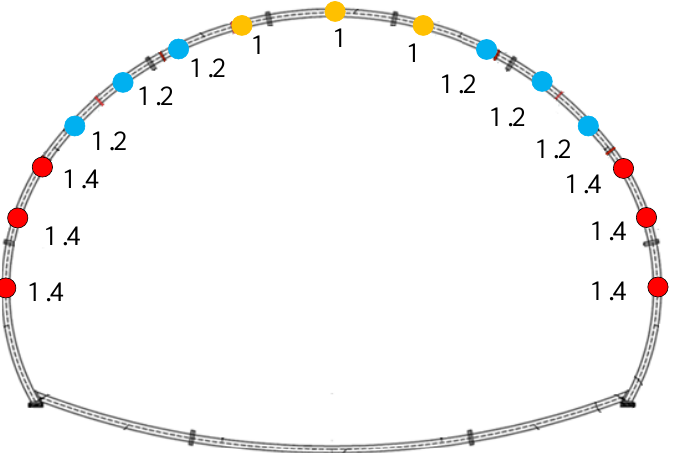
Figure 12. Load adjustment proportion distribution of adjusting units in cross section.